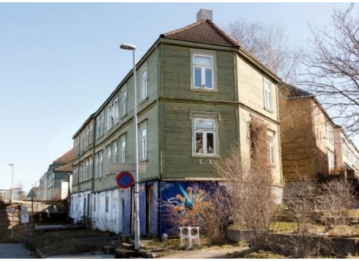
Figure 7. Strandveien 19 and 21 (Trondheim Municipality, 2016).